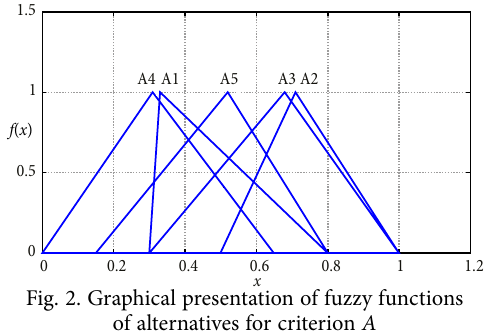
Fig. 2. Graphical presentation of fuzzy functions of alternatives for criterion A